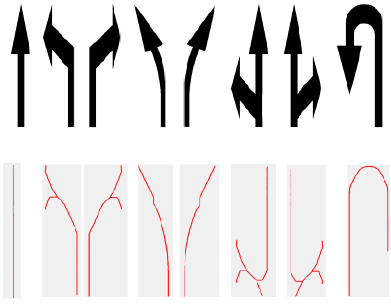
Figure 4. Marking template and skeleton template